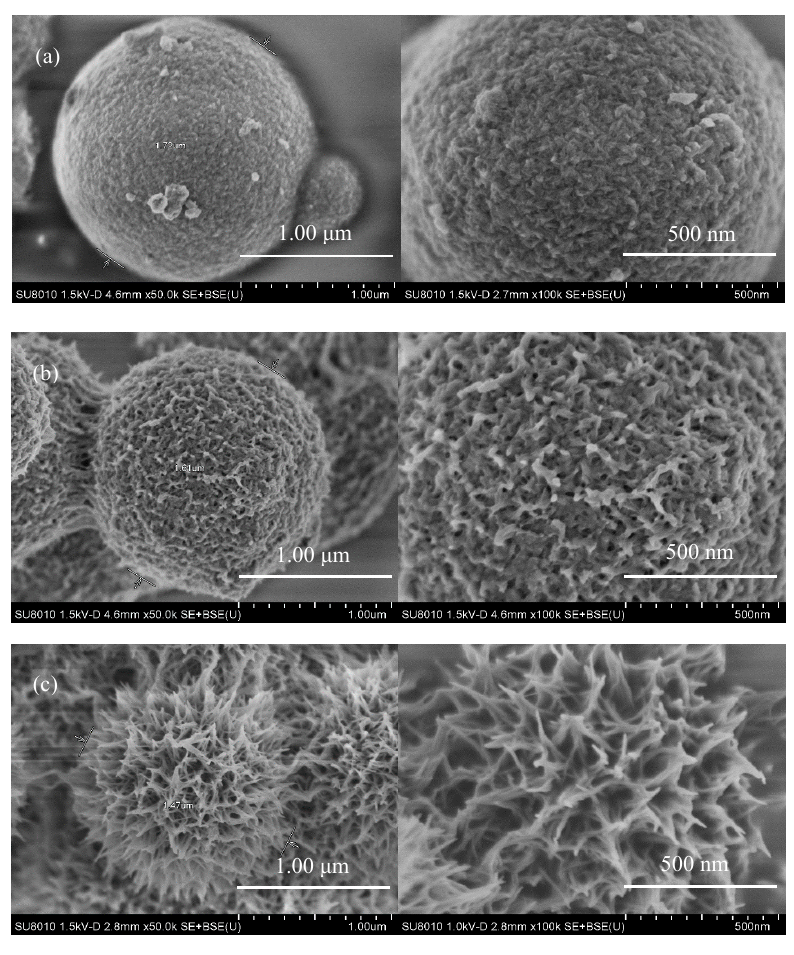
Figure 5. SEM images of schwertmannite under different treatments: ( a ) n(Fe)/n(K) = 200; ( b ) n(Fe)/n(NH4) = 3; ( c ) n(Fe)/n(Na) = 3.